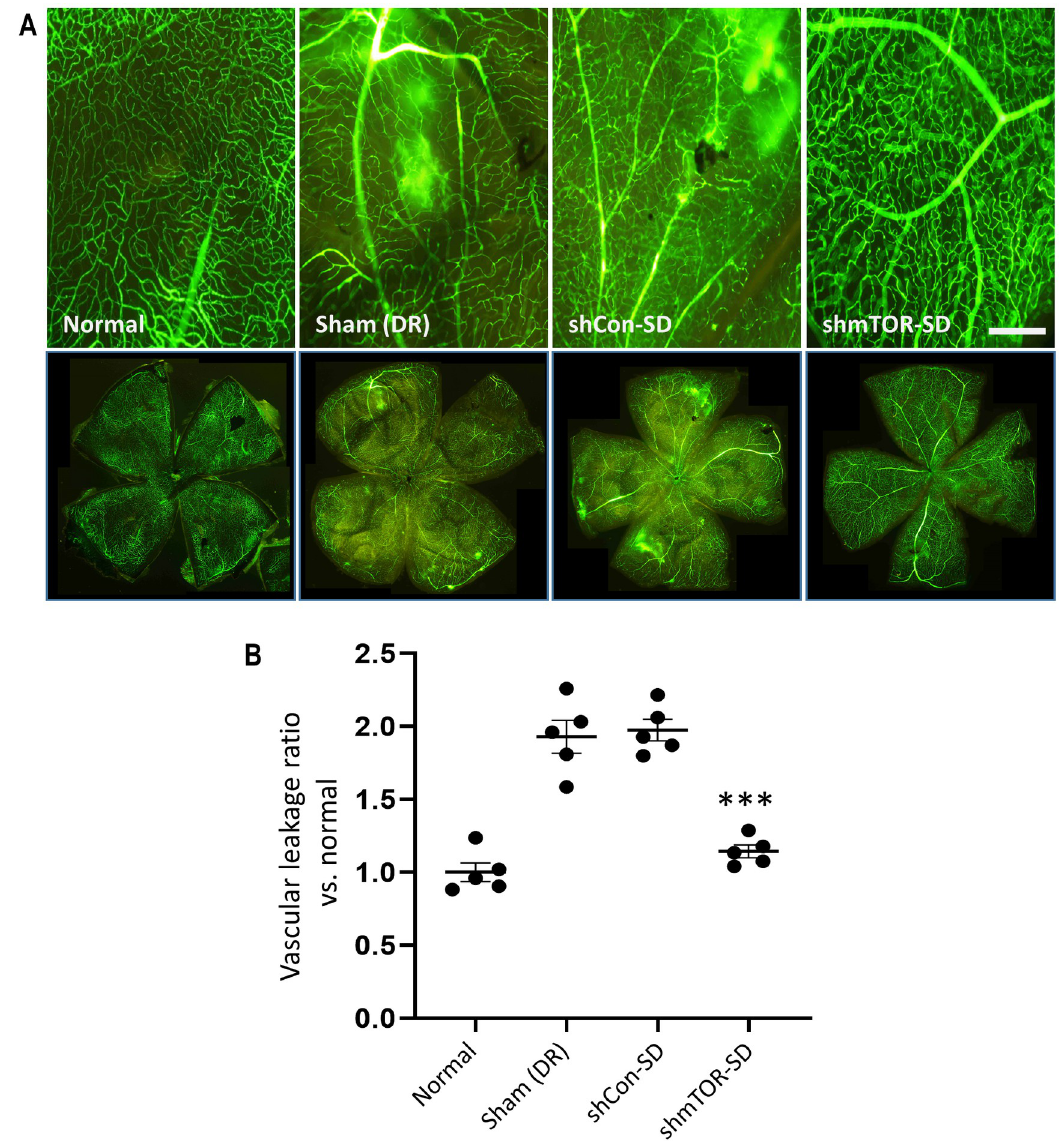
Fig 3. Vascular permeability visualized via FITC-dextran staining. (a) Significant amounts of retinal vessel leakage, appearing as indistinct regions of blurred staining, can be observed throughout the retinas of the sham-treated STZ-induced diabetic mouse models and those administered with the virus vector containing a control shRNA, whereas rAAV2-shmTOR-SD injection resulted in a marked decrease in vascular permeability. Scale bar = 50 μ m. (b) Vascular leakage levels were determined from 5 randomly sampled areas of the retinal flat mounts, and the quantifications normalized relative to mice not treated with STZ. Data represented as mean ± SEM (n = 5).